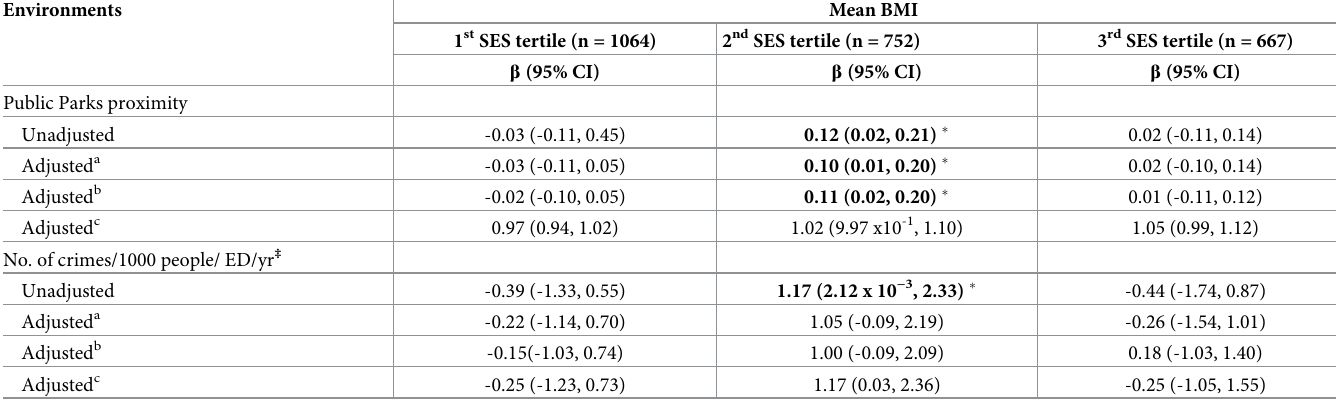
Table 4. SES-specific unadjusted and adjusted β coefficients (Confidence Intervals in brackets) for the association of public parks proximity and number of crimes/ 1000 people/ ED/yr with mean Body Mass Index. Environments